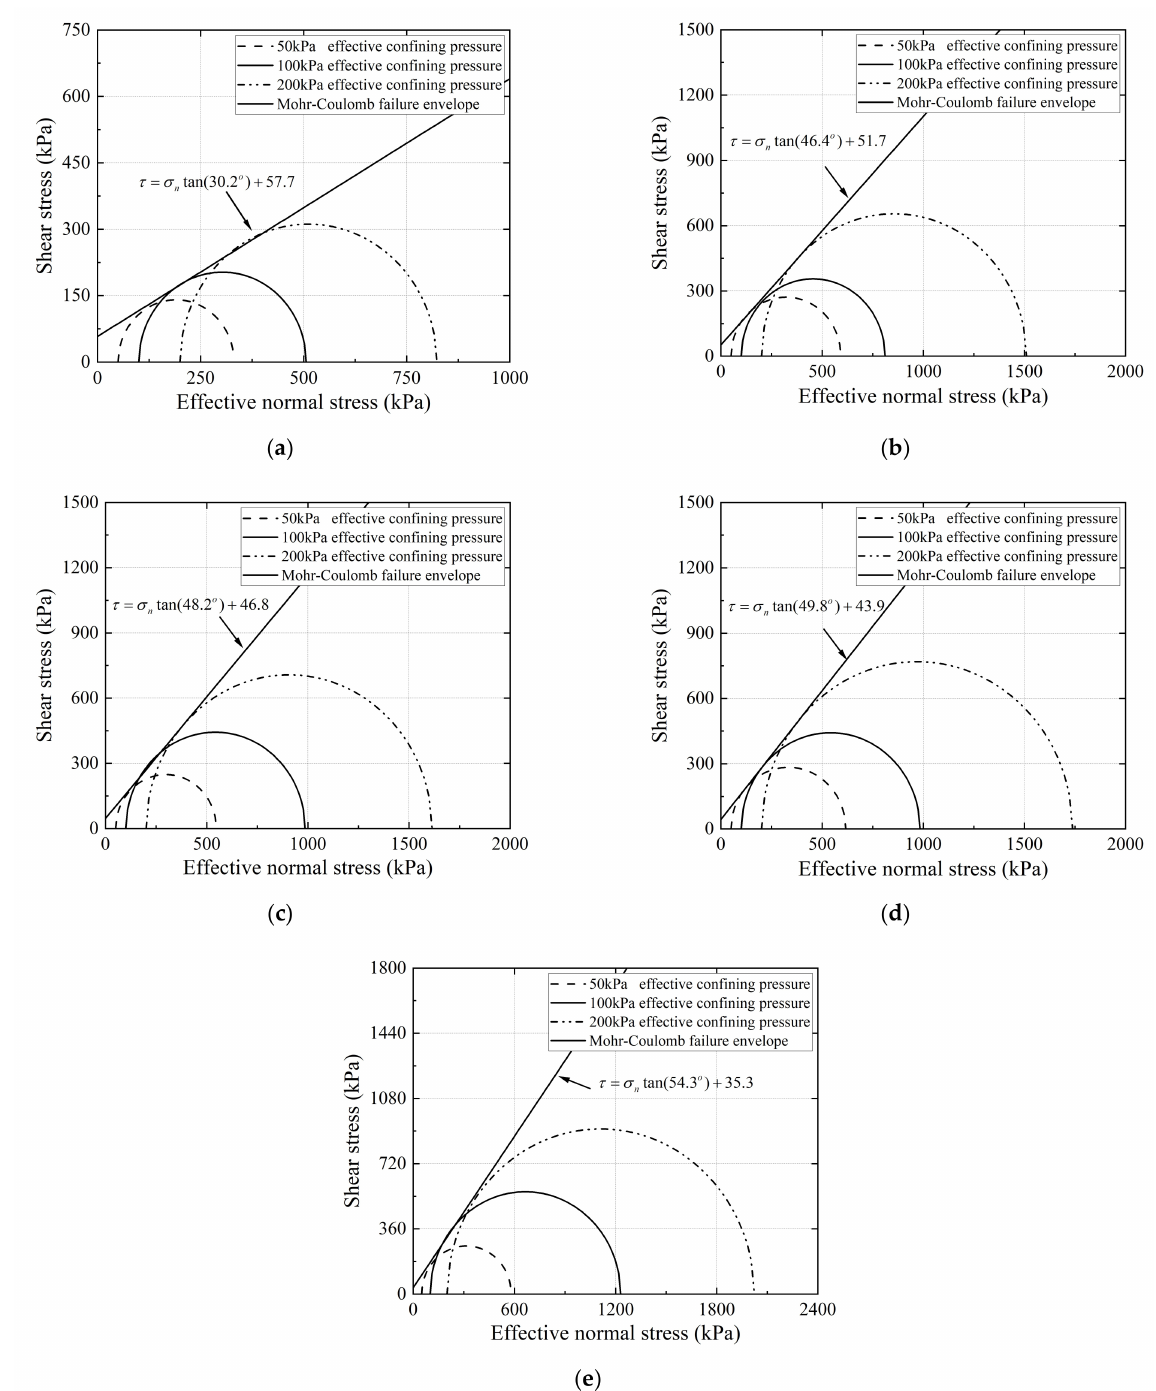
Figure 10. Mohr–Coulomb failure envelopes determined from the consolidated drained monotonic triaxial compression tests for recycled BDW aggregates with different gradations: ( a ) G/S = 1.0; ( b ) G/S = 1.6; ( c ) G/S = 1.8; ( d ) G/S = 2.0; and ( e ) G/S = 2.5.